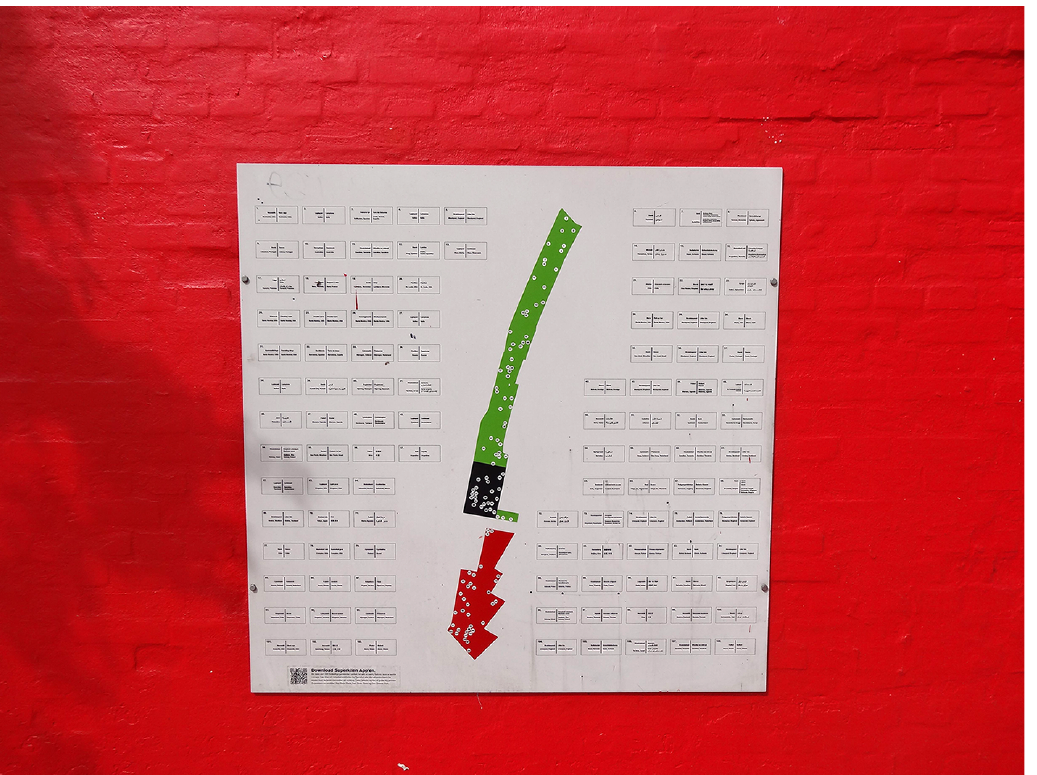
Figure 5. Sign on the wall showing the location of the 108 objects at Superkilen. All object are named in Danish and their original language. Photo: Ida Sandström.